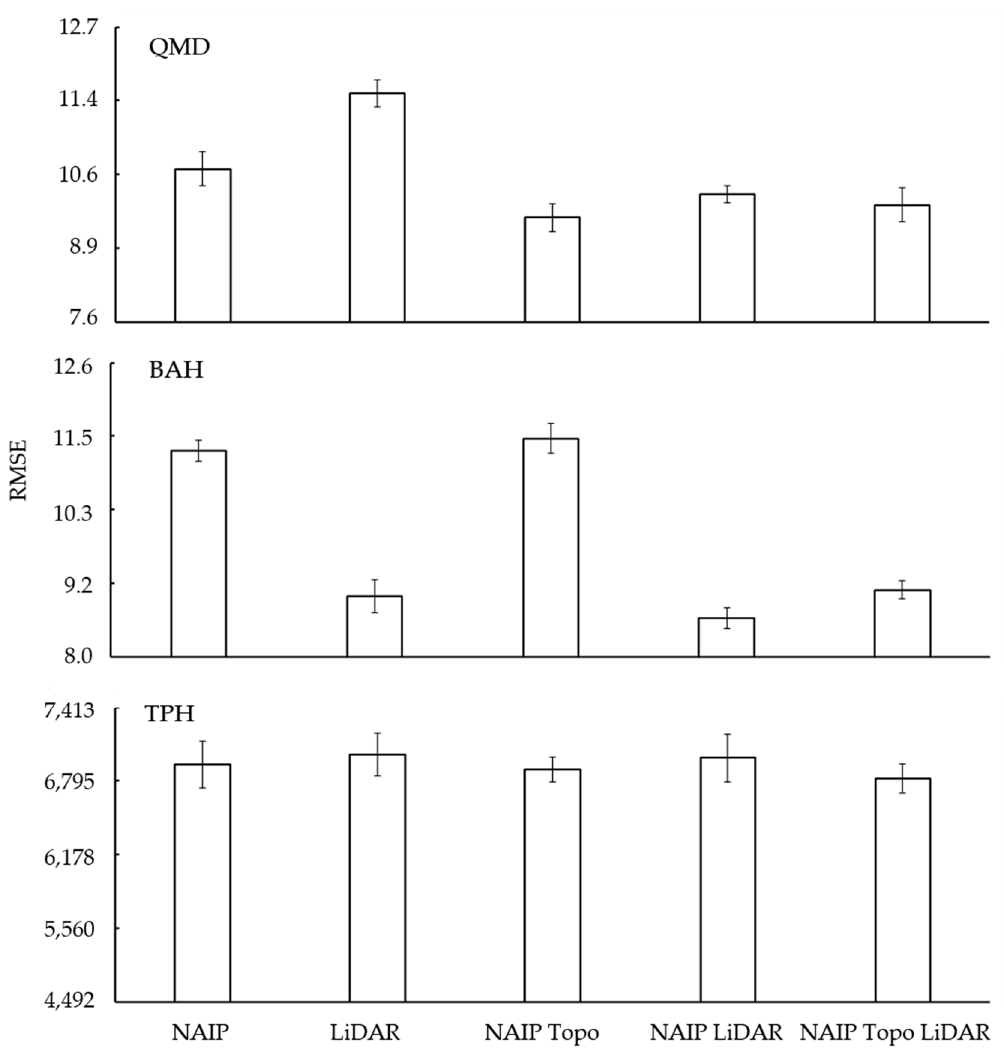
Figure A3. Variation in out of bag root mean squared error (RMSE) for 10 quadratic mean diameter (QMD), basal area per hectare (BAH), and trees per hectare (TPH) Random Forest models. Table A1. Description and summary statics of field and remote sample observations.